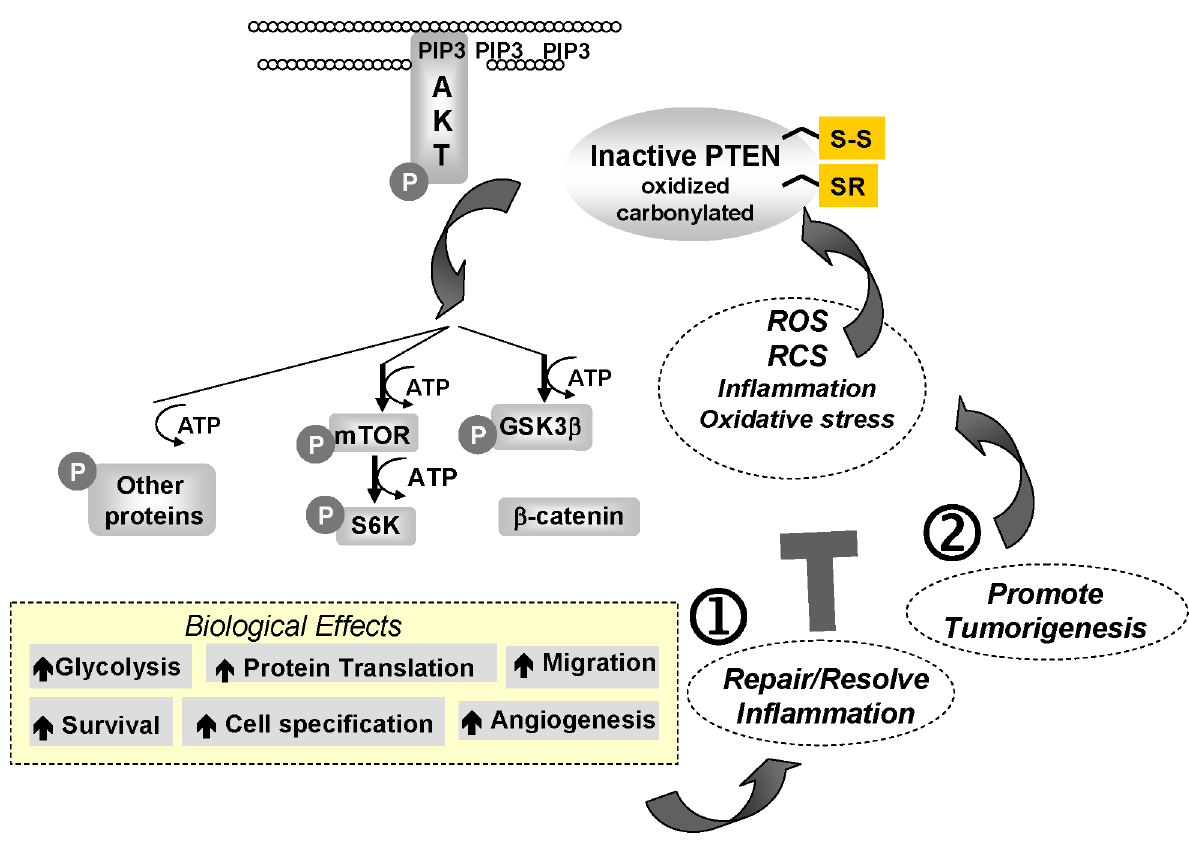
Figure 7. Model Depicting Hypothetical Roles of PTEN Alkylation in Inflammation and Cancer.